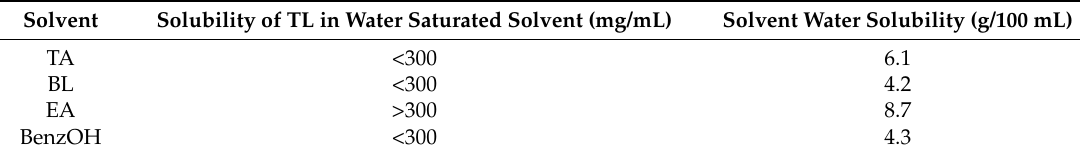
Table 1. Solubility (mg/mL) of trilaurin (TL) in water partially miscible solvents and water solubility of the solvents (25 ◦